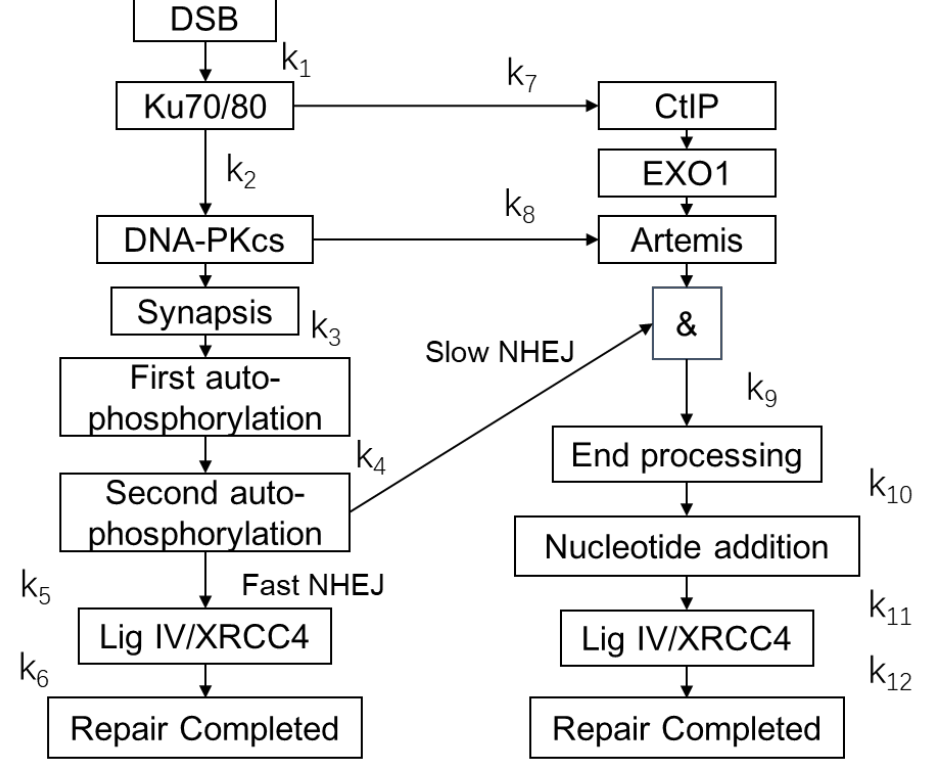
Figure 9. Scheme of the DNA repair model with fast and slow compartments. Ku70/80, DNA-PKcs, CtIP, EXO1, Lig IV, XRCC4, and Artemis are proteins attending NHEJ. The k 1 to k 12 are rate constants of repairing processes listed in Table 1.